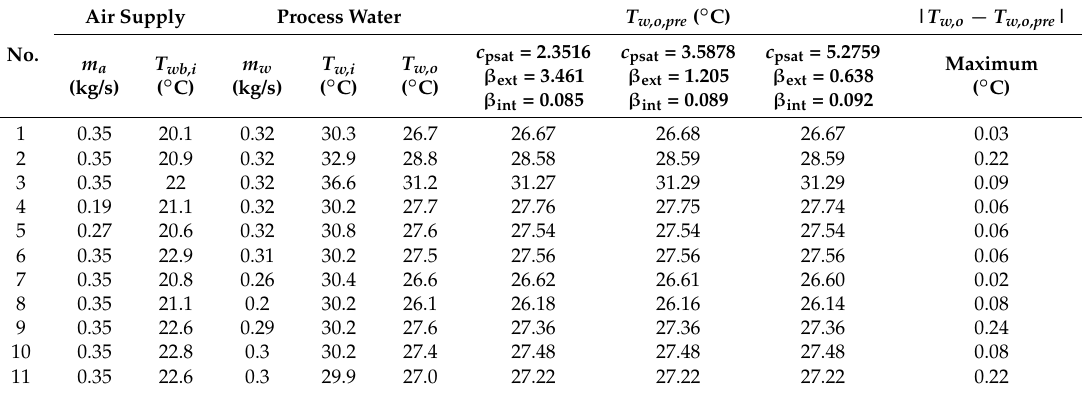
Table 2. Comparison of the predicted thermal performance versus the measurements for the